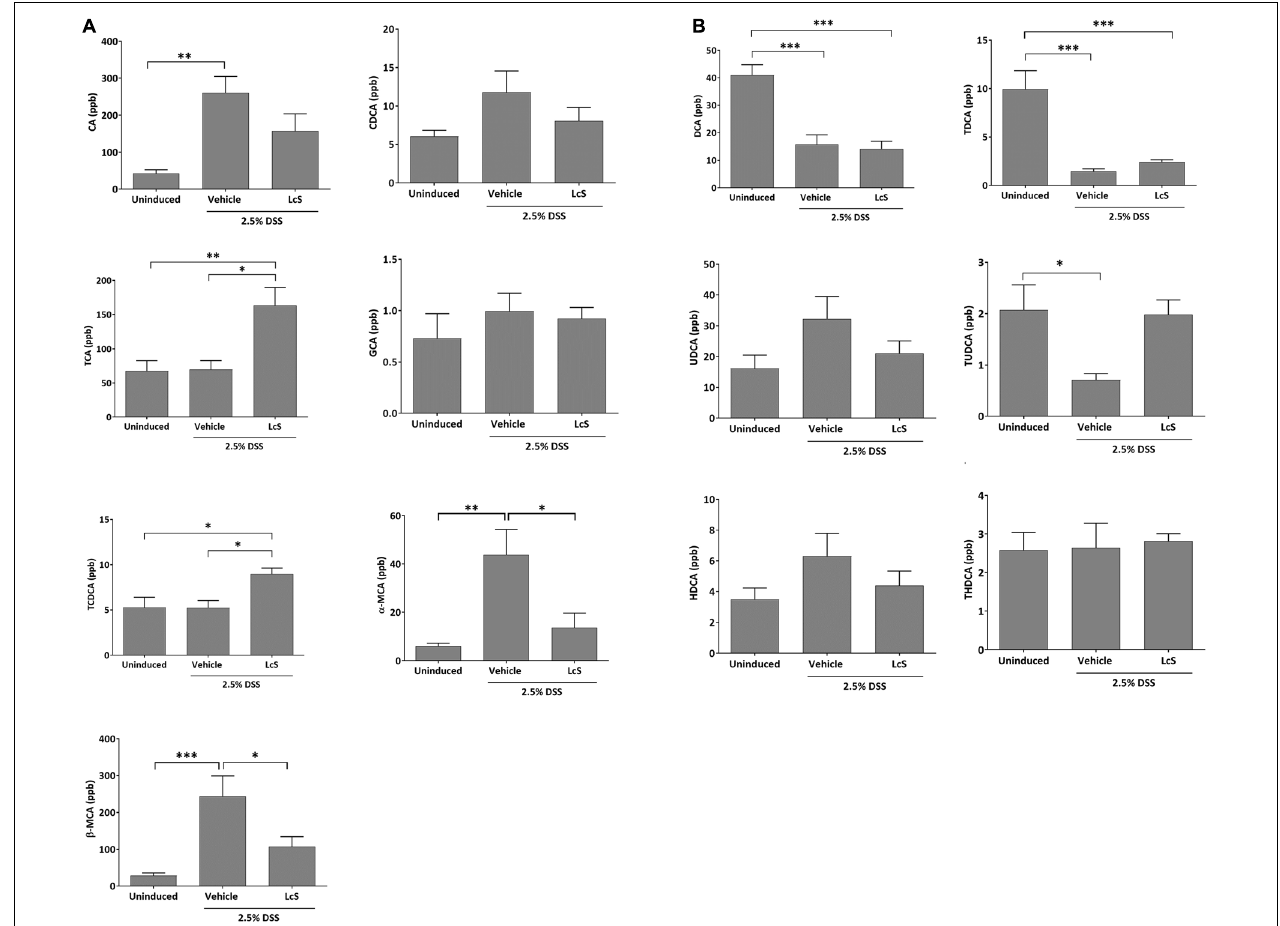
FIGURE 4 | LcS altered bile acid metabolism in DSS-induced mice. Levels of (A) CA, CDCA, TCA, GCA, TCDCA, α -MCA, and β -MCA, and (B) DCA, TDCA, UDCA, TUDCA, HDCA, and THDCA in mouse plasma. Data are expressed as mean ± SEM; ∗ p < 0.05, ∗∗ p < 0.01, ∗∗∗ p <